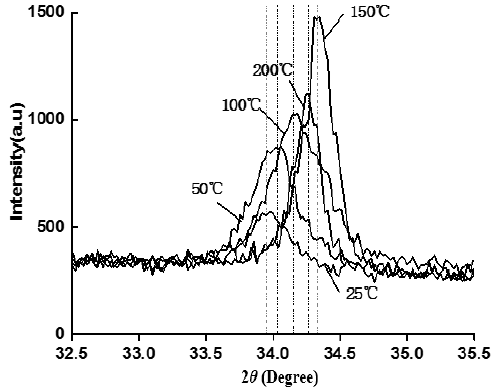
Figure 5. XRD spectra of the ZnO waveguide layer.